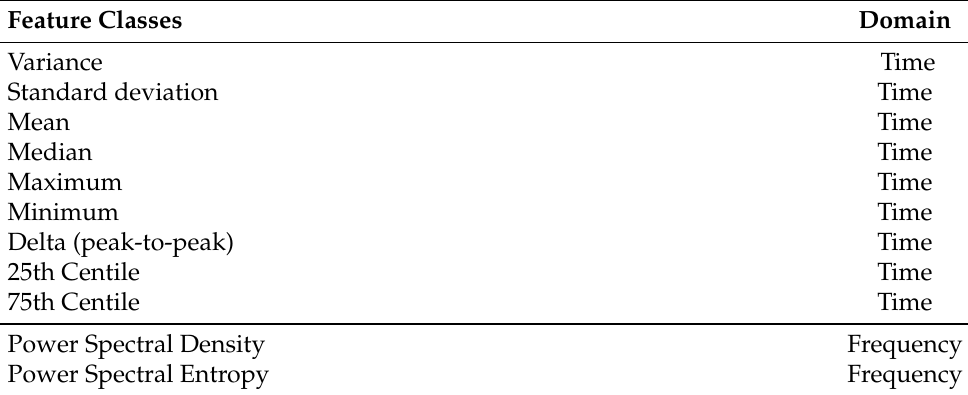
Table 4. List of extracted time and frequency domain